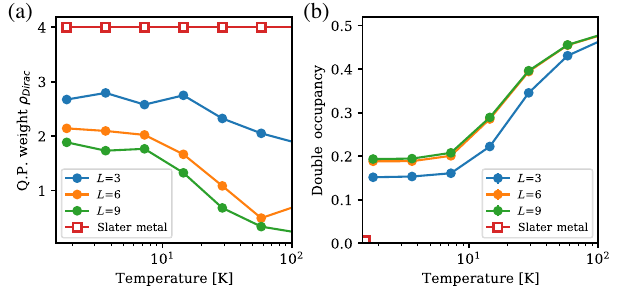
FIG. 4. Characterization of the strongly correlated semimetal phase at κ ¼ 0 . 3 . (a) Proxy for the quasiparticle weight Z of a gapless Dirac particle in comparison to the noninteracting Dirac metal. (b) Flavor-resolved double occupancy averaged over all spin, valley, and momenta